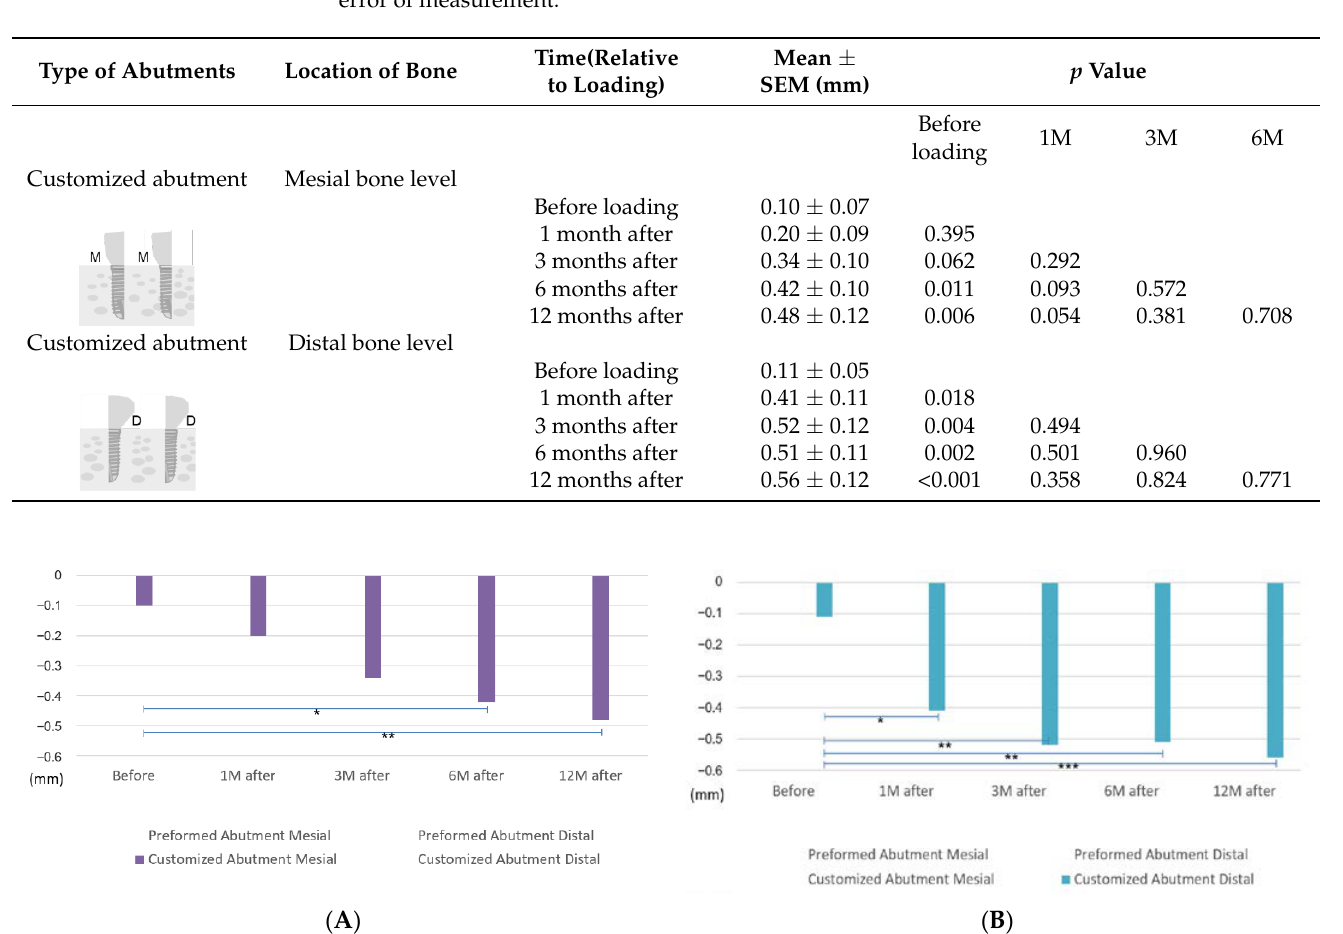
Table 6. Mesial and distal marginal bone levels in the CAs. CA, customized abutment; SEM, standard